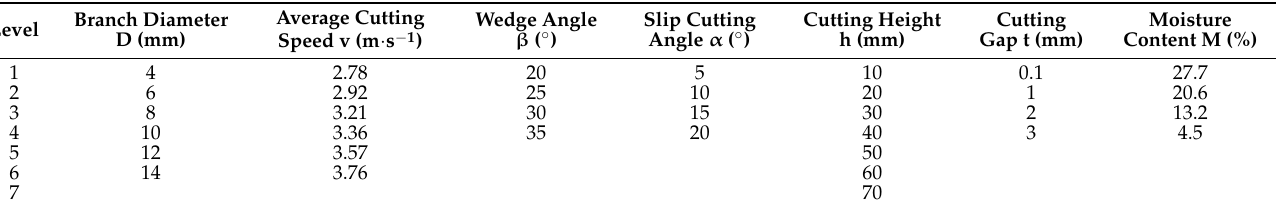
Table 1. Single-Factor Test Factors and Levels.